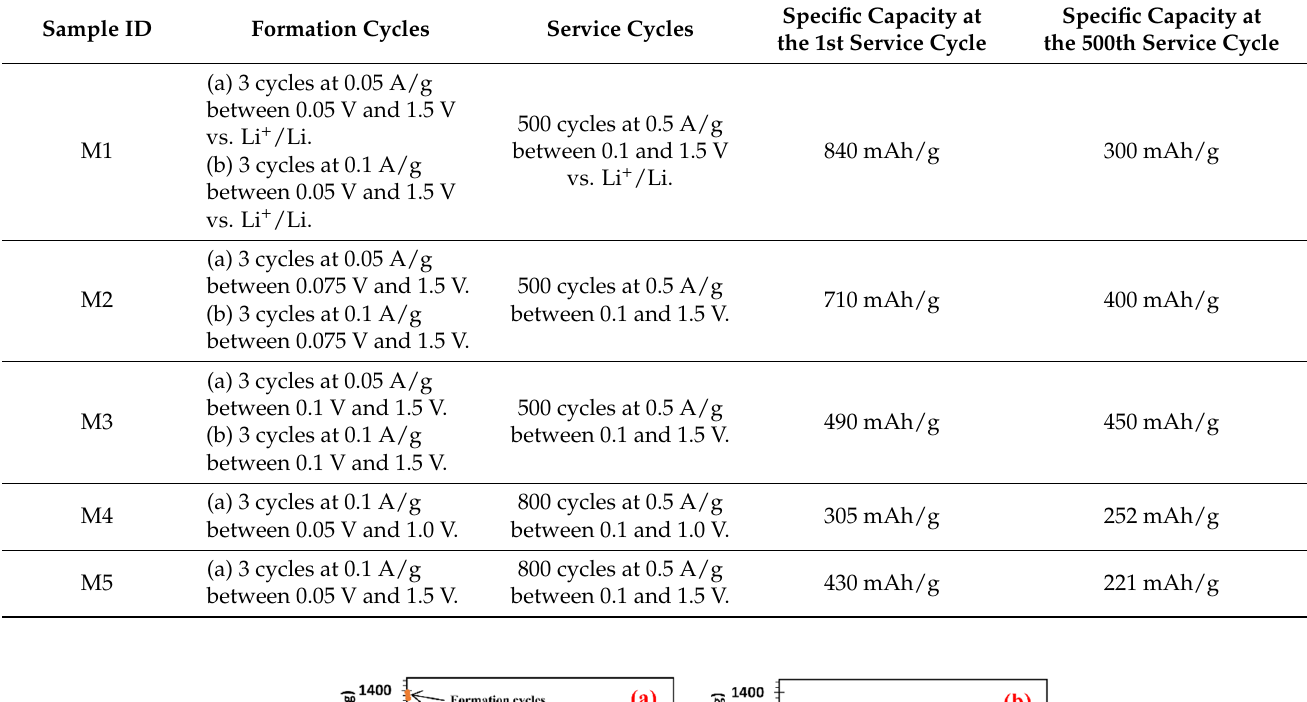
Table 2. Charge/discharge protocol and specific capacities at selected cycles for M1–M5 cells.